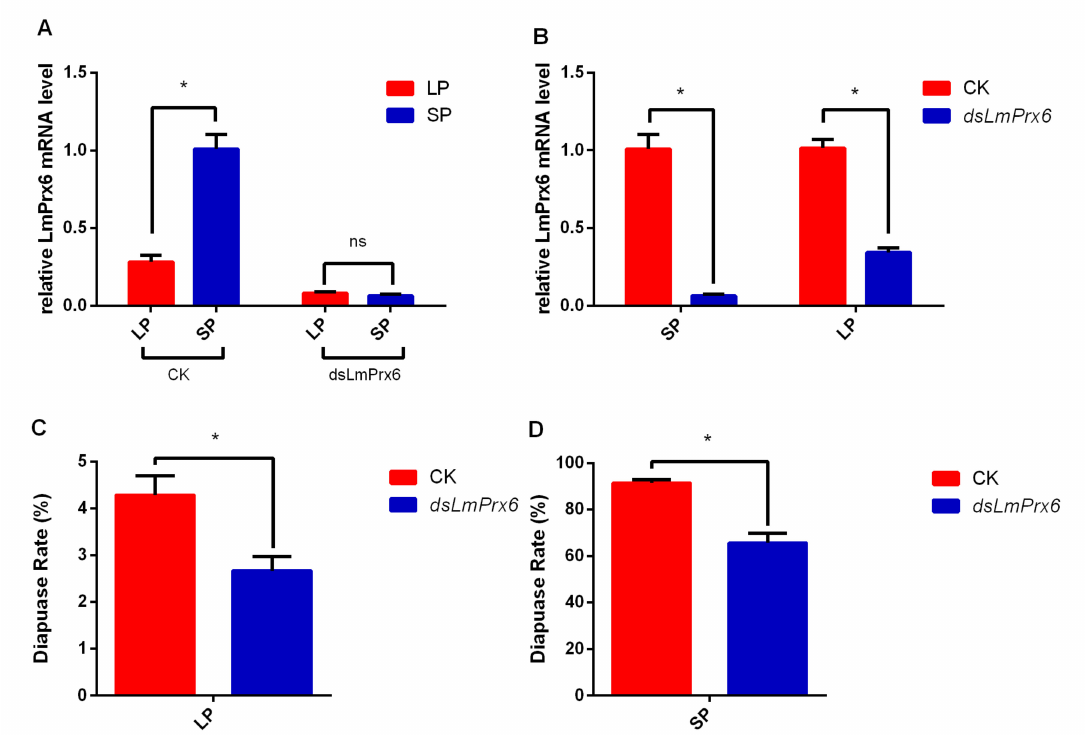
Figure 4. ( A ), Relative mRNA level of LmPrx6 in the whole body of adult females under an SP (short photoperiod) and LP (long photoperiod) with and without dsLmPrx6 injection. ( B ), The comparison of the expression of LmPrx6 with and without dsLmPrx6 injection under SP and LP. ( C ), Diapause rate detected after injecting dsLmPrx6 under LP. ( D ), Diapause rate detected after injecting dsLmPrx6 under SP. All results were expressed as means ± standard error (SE) of the three replicates. * Indicates probability level of p < 0.05 by Student’s t